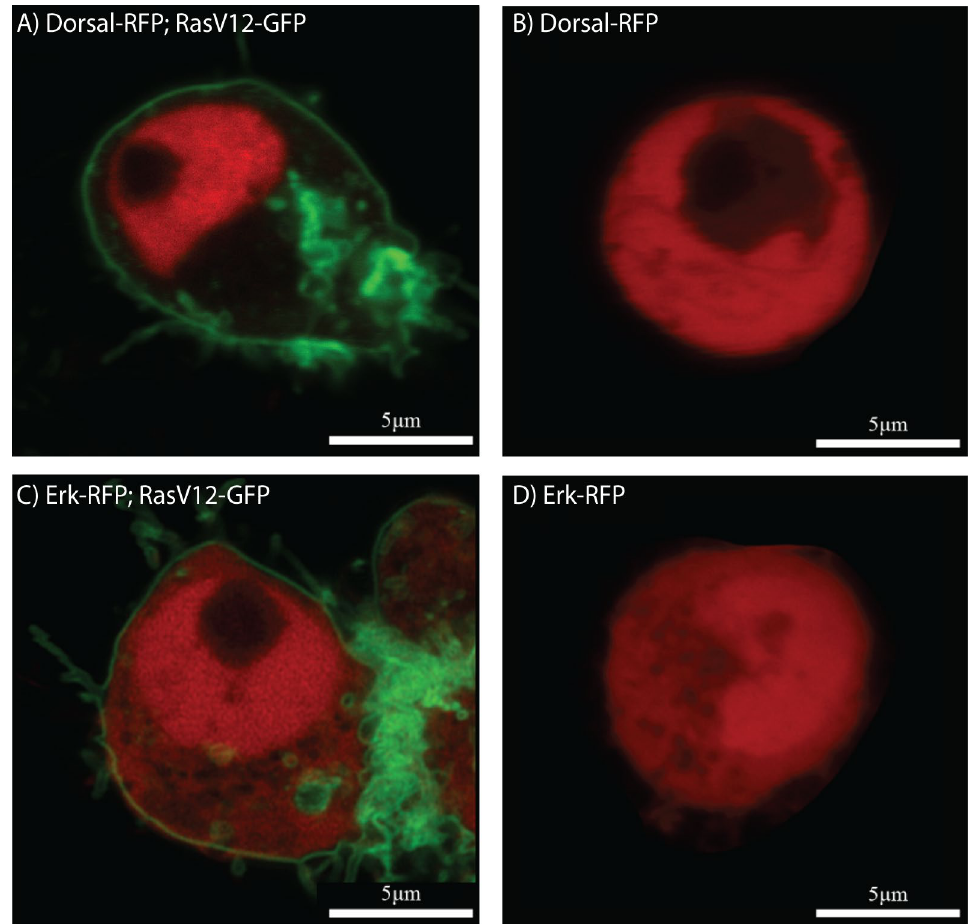
Figure 5. Dorsal and Erk localization in vitro. ( A ) Nuclear localization of Dorsal (red) in S2R+ cell expressing the gain of function Ras V12 (green). ( B ) Nuclear exclusion of Dorsal in S2R+ cell in the absence of RasV12 expression. Ubiquitous expression of Erk (red) in both cytoplasm and nucleus of S2R+ cell both ( C ) in the presence and ( D ) absence of Ras V12 (green). The black spot in the nucleus in ( A – C ) is the